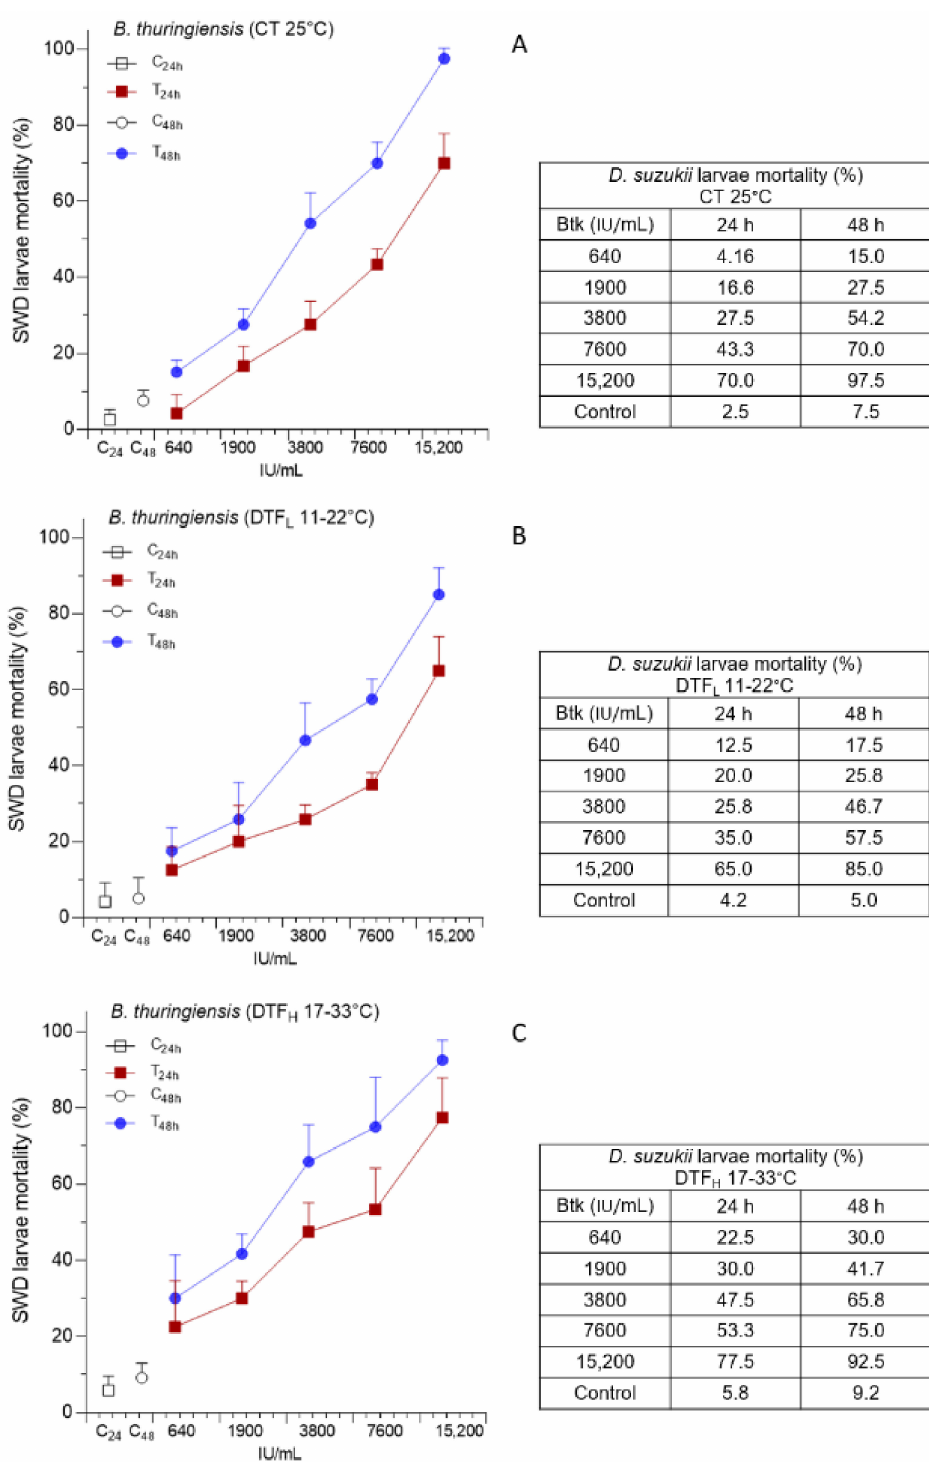
observed between 24 and 48 h for DTF H and, in some cases (800 and 1600 IJ/mL) for CT, while only at the maximum concentration for DTF L (Supplementary Materials Table S2).